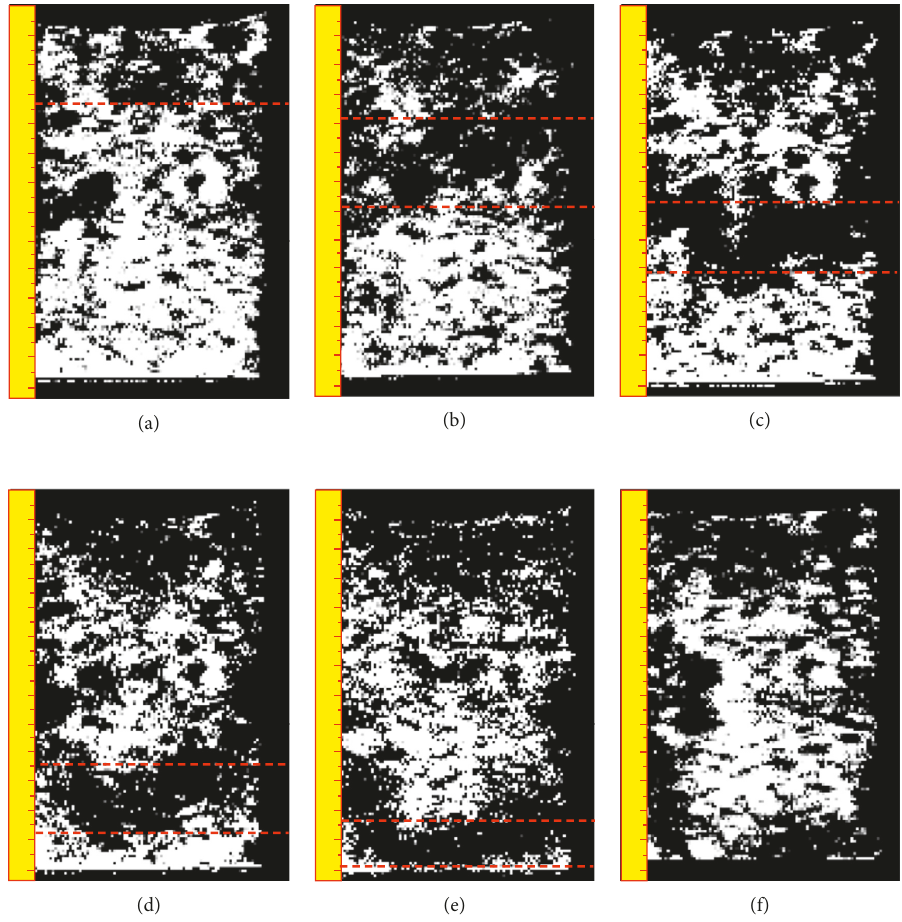
Figure 12: Phase of (NH 4 ) 2 SO 4 solution (2.5%). (a) 7h, (b) 8h, (c) 9 h, (d) 10h, (e) 11h, and (f)